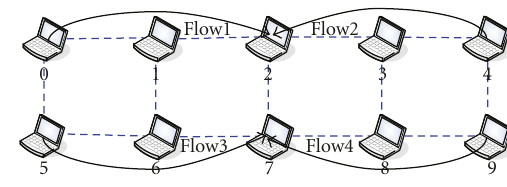
Figure 4: A simple network topology.